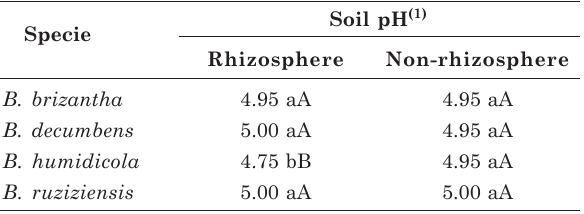
Table 1. pH values in the rhizospheric and non- rhizospheric soils of B. brizantha , B. decumbens , B. humidicola and B. ruziziensis (mean of five evaluations)